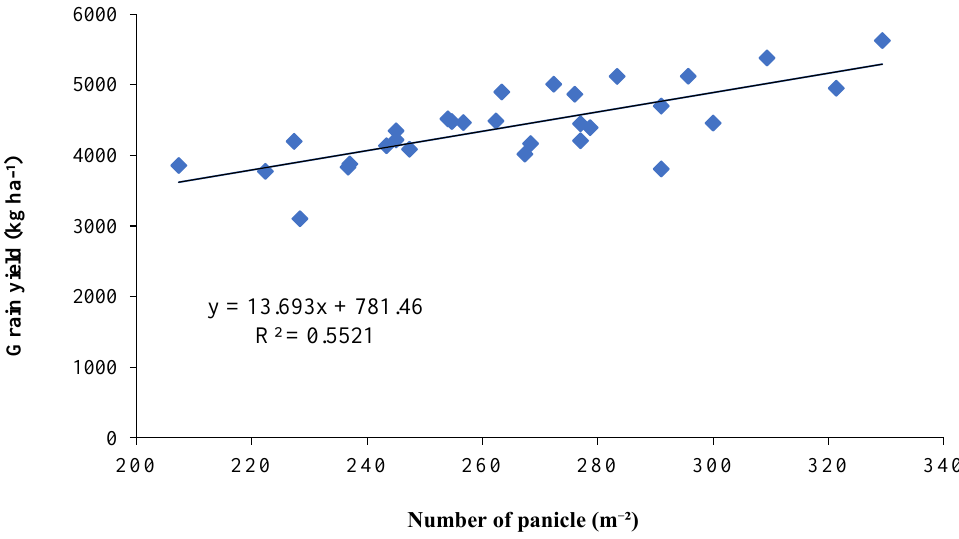
y = 13.693x + 781.46